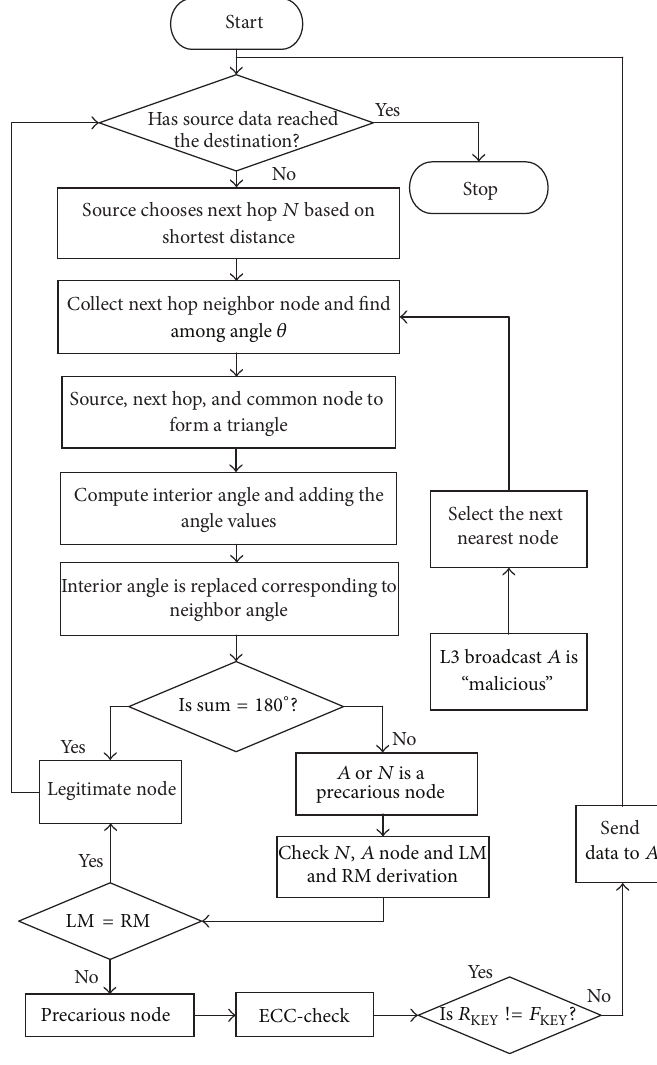
Figure 8: Flowchart of ACFG